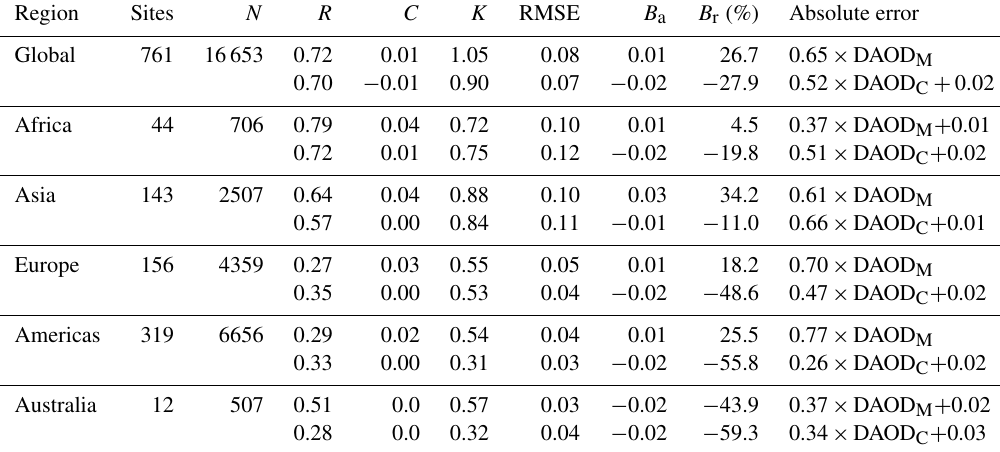
Table 3. Statistical parameters and absolute error by continents using the method indicated in Fig. 1. Sites is the number of AERONET sites involved; N is the number of MODIS, CALIOP and AERONET matchups. R is correlation coefficient; C is the intercept of the linear fit; K is the slope of the linear fit; RMSE is root mean square error of the linear fit; B a is the absolute bias; B r is the relative bias. For cells with two rows of values, the upper row is for MODIS, the lower row is for CALIOP.